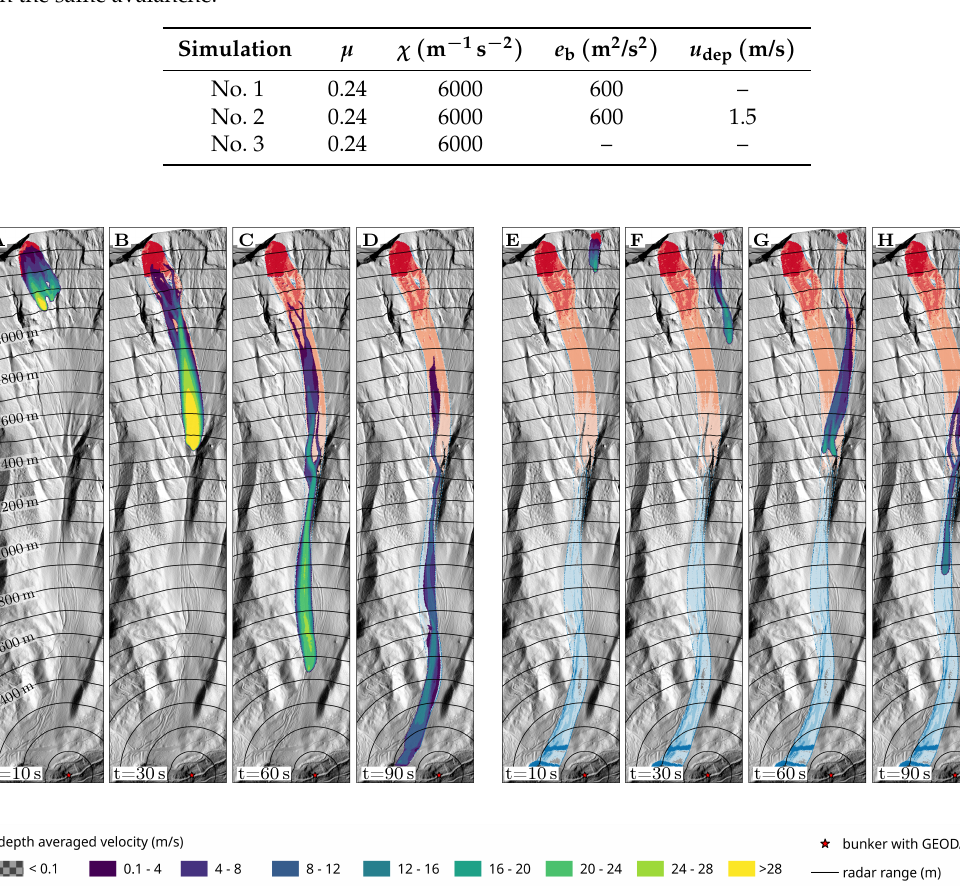
Table 1. Summary of simulation parameters for both consecutive avalanches #0017 and #0019. µ , χ and e b are determined with simulation no. 1 on avalanche #0017, u dep resulted from simulation no. 2 on the same avalanche.